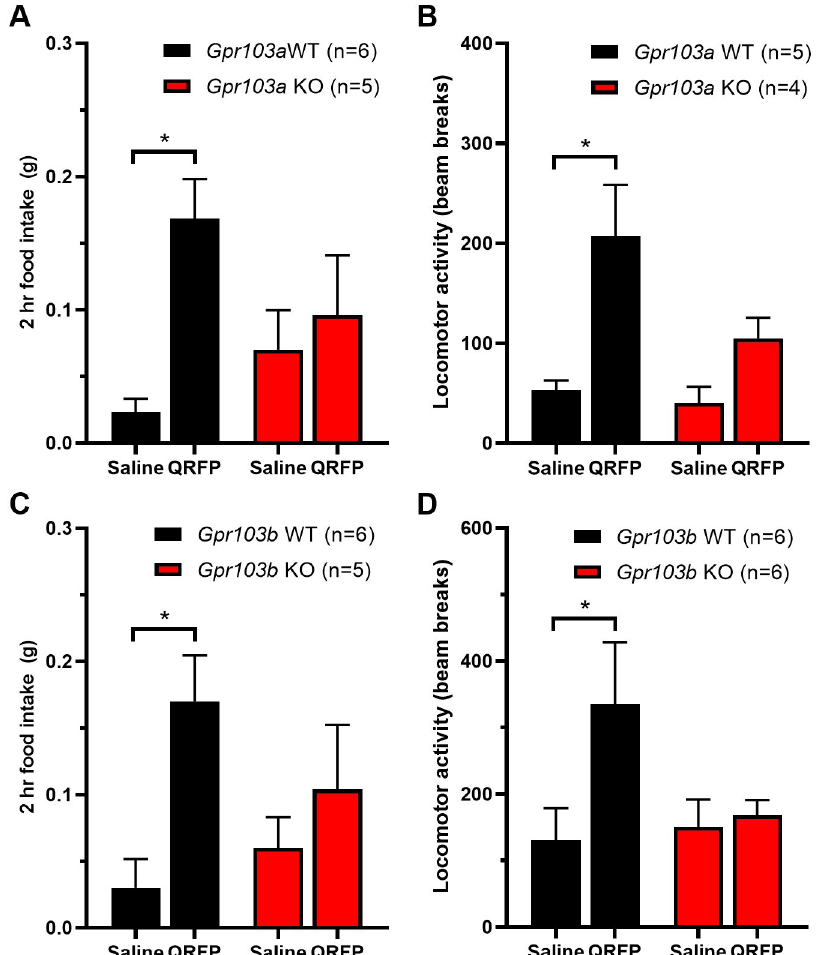
F 1,7 = 14.2). (C and D) The same is true in Gpr103b knock-out mice (food intake F 1,9 = 6.01; activity F 1,10 = 11.17). Two-way ANOVA with Sidak’s post hoc test. � p <